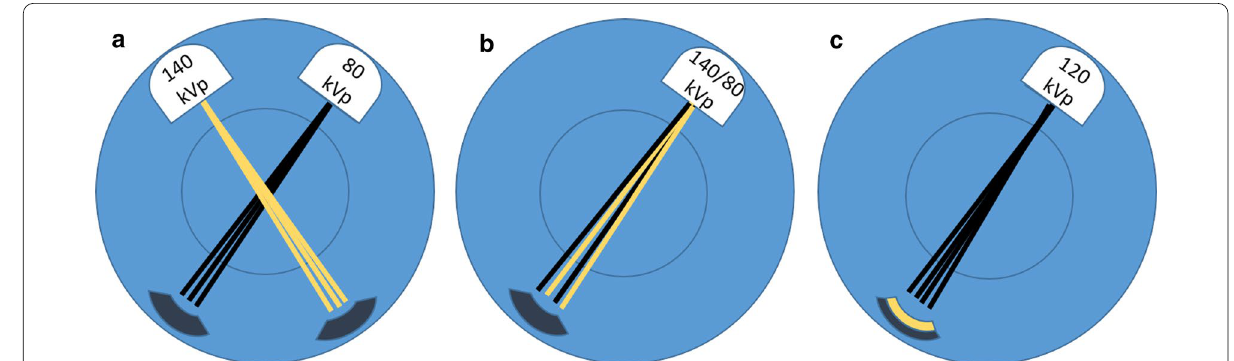
Fig. 1 The main acquisition techniques currently in the market for spectral imaging: dual source dual energy CT ( a ), rapid kV switching ( b ) and detector based spectral imaging ( c